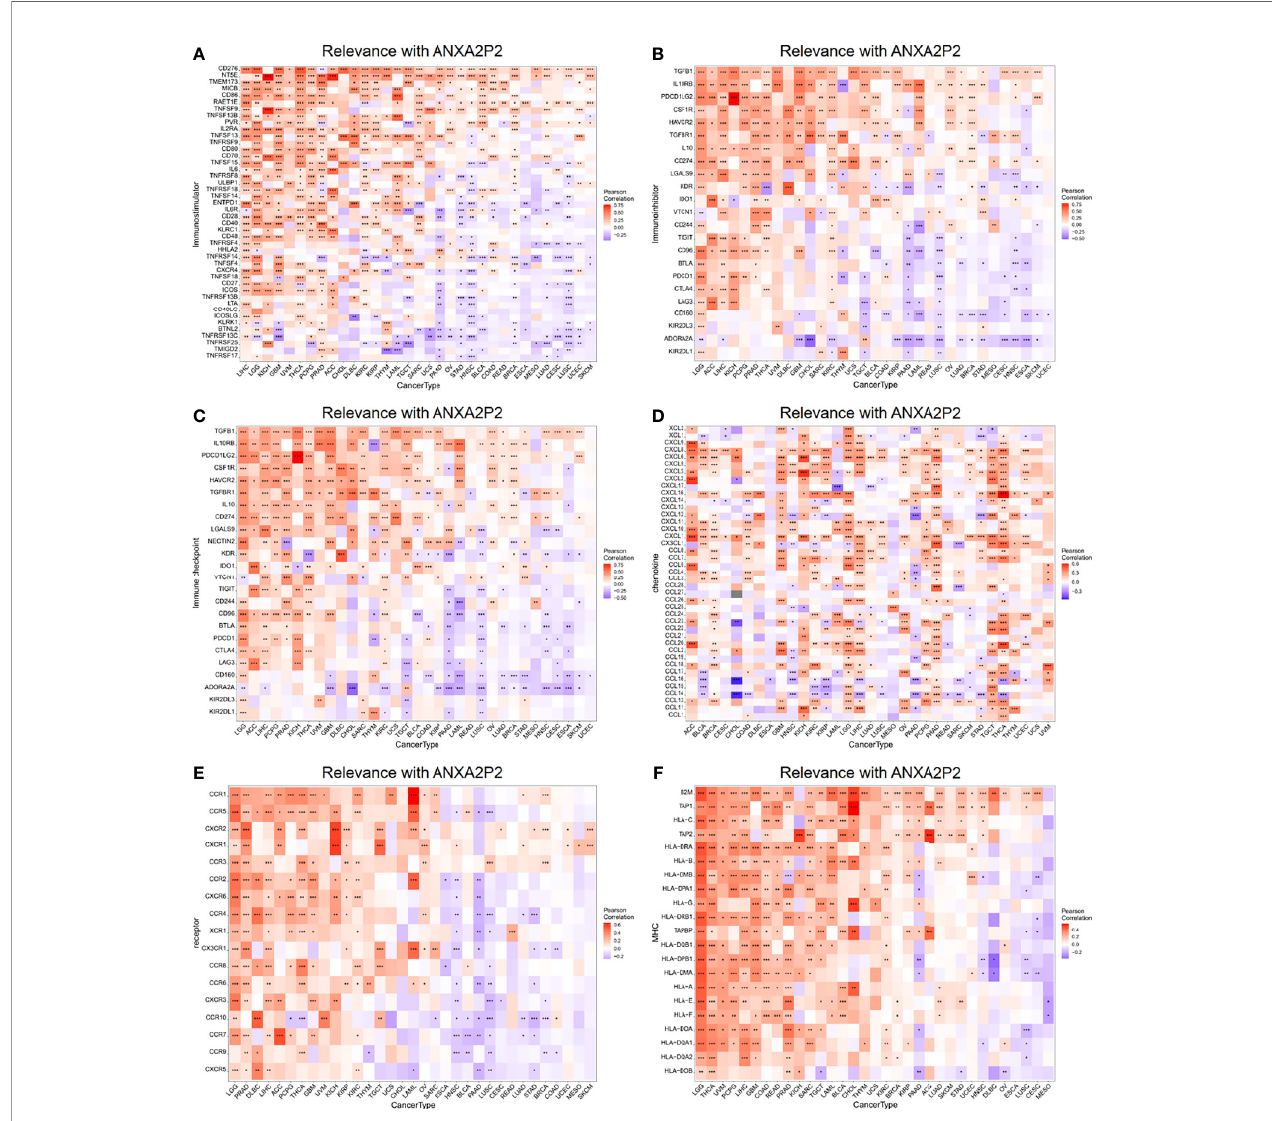
FIGURE 8 | Relevance with ANXA2P2 and immune-related genes. (A) Immunostimulatory; (B) immunoinhibitory; (C) immune checkpoint; (D) chemokine; (E) chemokine receptor; and (F) MHC molecule. *P < 0.05, **P < 0,01 and ***P <